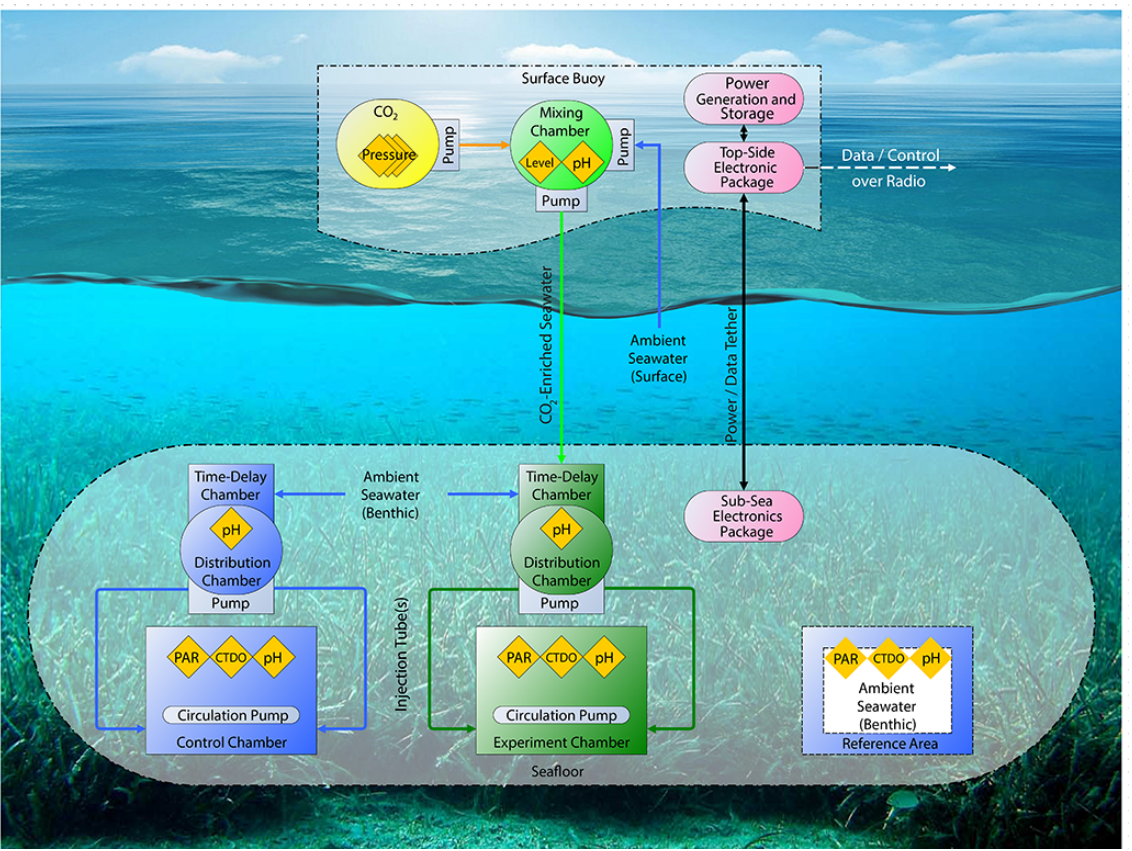
Figure 1. Conceptual diagram of a FOCE system. The number of control, experiment, and reference areas vary depending on the experimental design and budget. Additional sensors are also optional. PAR: photosynthetically active radiation; CTDO: conductivity, temperature, salinity, and oxygen sensors. See the main text for definitions of the